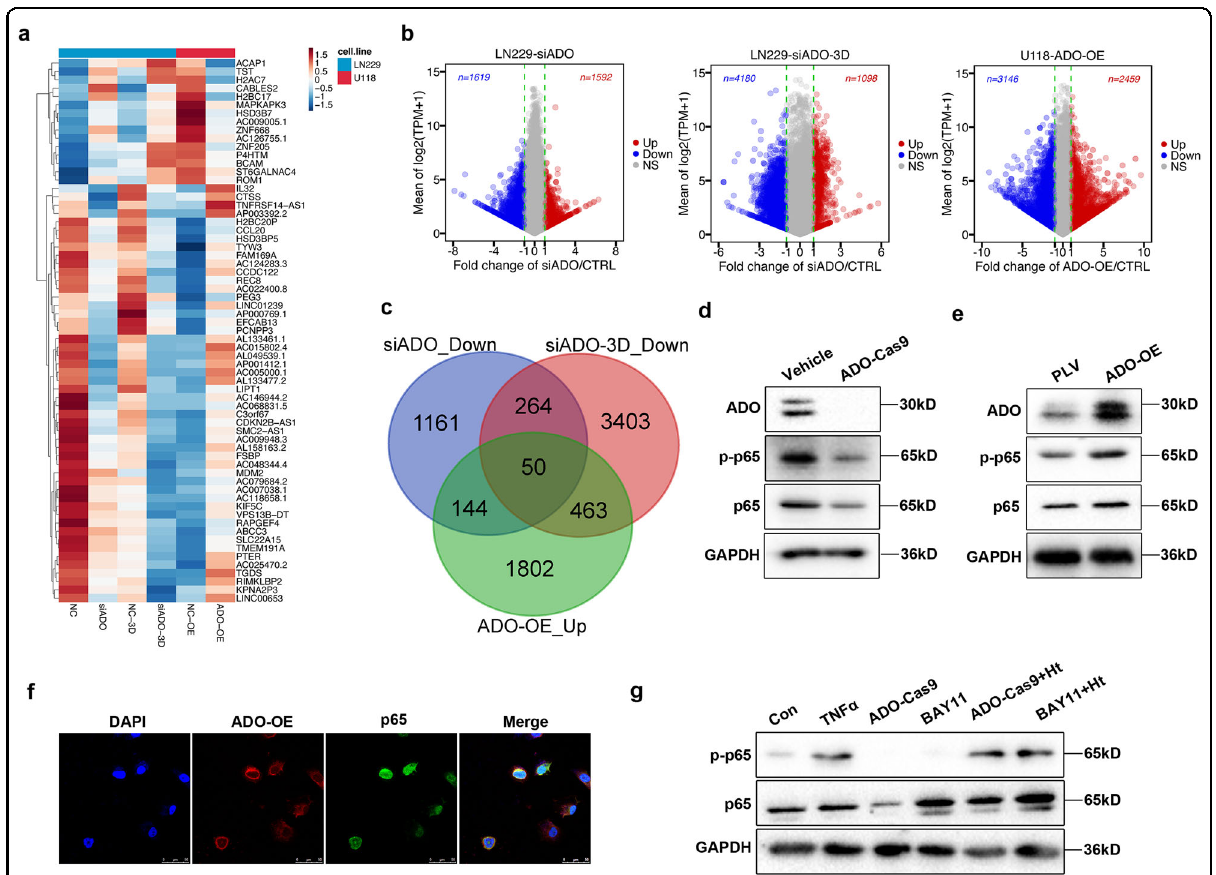
Fig. 4 ADO promotes NF- κ B pathway activation. a , b RNA-seq analysis in three paired experiments: ADO knockdown and controls under both 2D and 3D (LN229-siADO-derived spheroids) cultural conditions, and U118 ADO-OE cells and control groups. c Venn diagram representing overlapping candidates between three pairs of RNA-seq. d Phosphorylated p65 (p-p65) and total p65 proteins levels were analyzed in LN229 ADO-Cas9 cells and e U118 ADO-OE cells and their respective controls by immunoblotting. f ADO and p65 co-staining in U118 ADO-OE cells. Scale bars = 50 μ m. g LN229 cells were treated with TNF α (2 μ M) or NF- κ B inhibitor BAY11-7082 (2 μ M) to examine the effects of co-treatment of hypotaurine with ADO- Cas9 or BAY11-7082 on p-p65 and total p65 protein levels. Data represent three independent experiments with similar